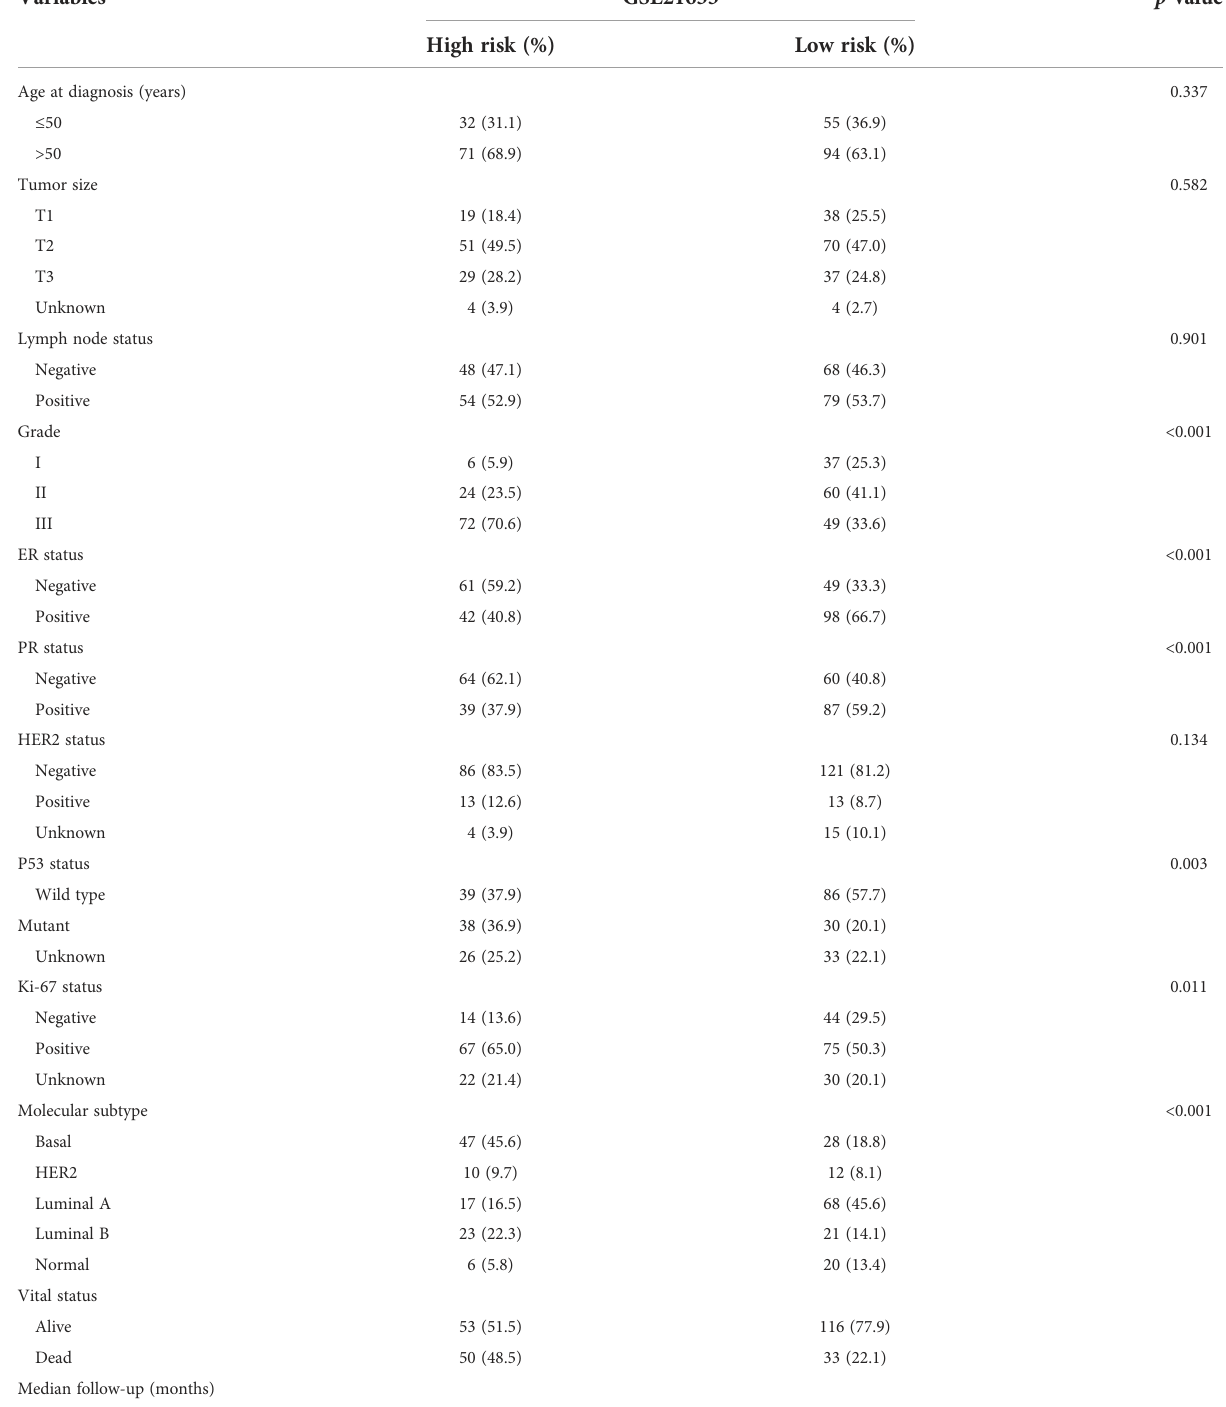
TABLE 2 Clinicopathologic characteristics of breast cancer patients according to the senescence-related